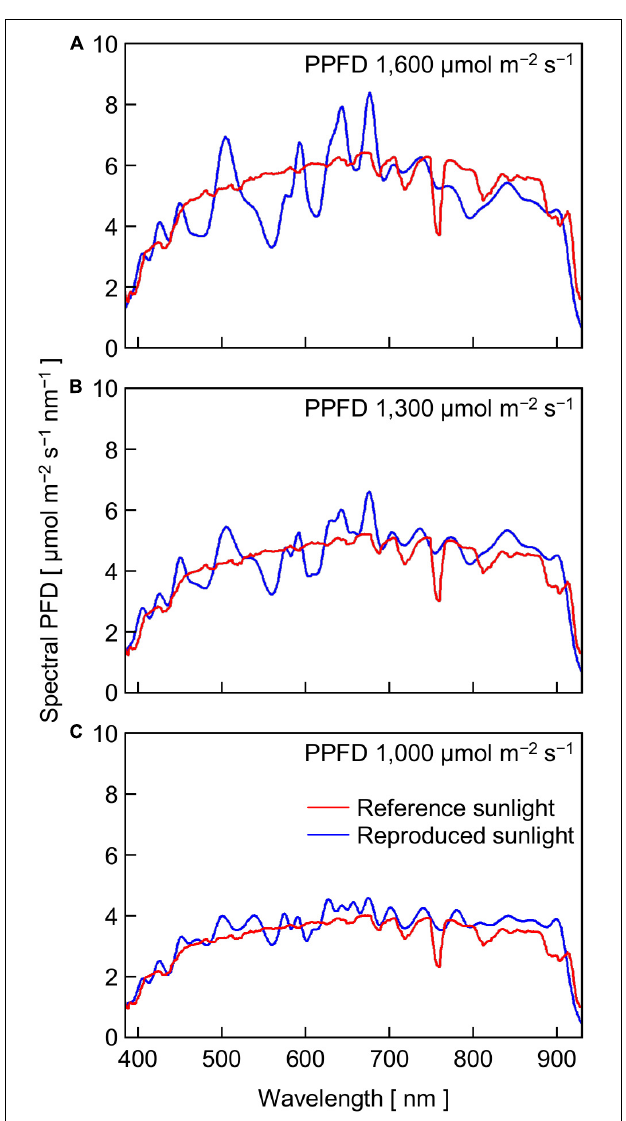
FIGURE 5 | The SPDs of reference sunlight at PPFDs of 1,600 (A) , 1,300 (B) , and 1,000 (C) µ mol m − 2 s − 1 and reproduced sunlight of which SPDs were approximated to those of the reference sunlight with the LASS